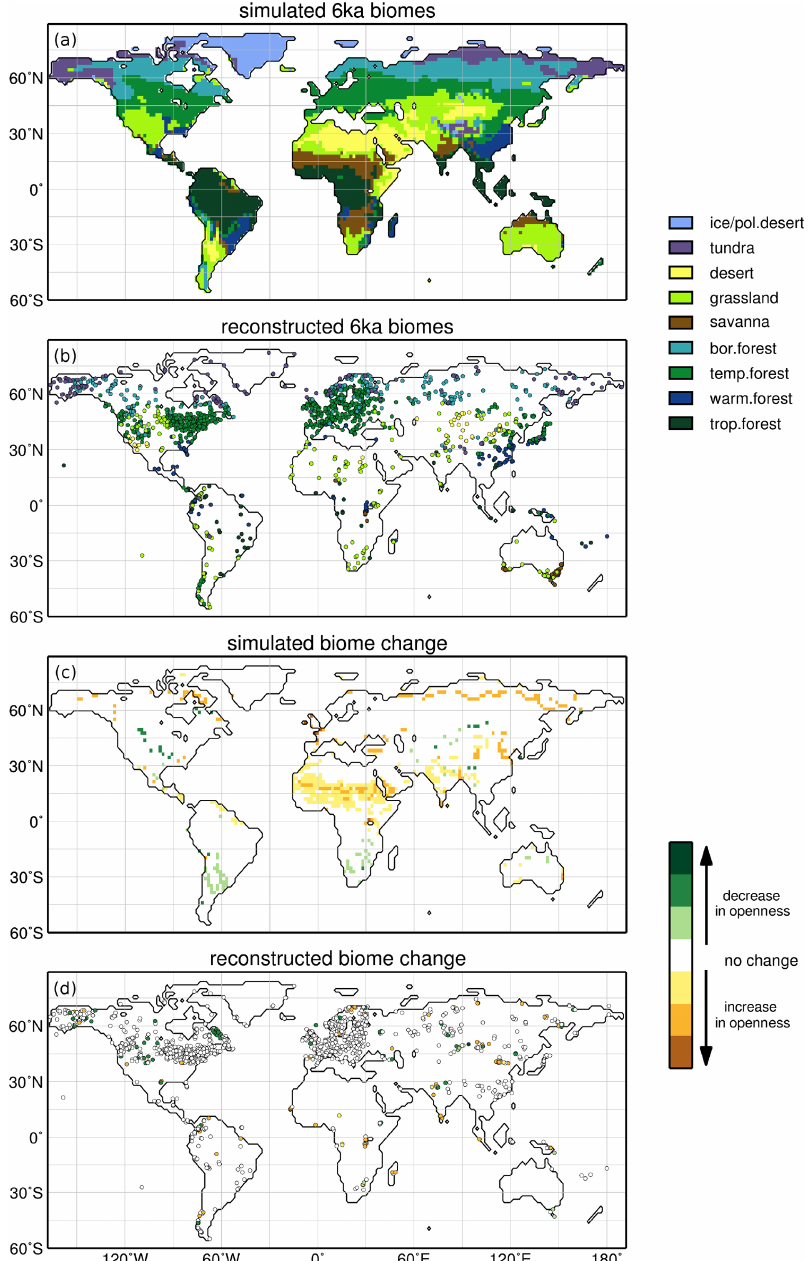
Figure 1. Simulated (a) and reconstructed (b) biomes for the 6ka time slice and the simulated (c) and reconstructed (d) change in vegetation between 6ka and the pre-industrial (PI) era, expressed in terms of landscape openness. To assess the biome change, the biomes have been further grouped into the main categories of forest, savannas, grassland/tundra and desert. A decrease in openness describes the transition from biomes indicating more open landscape to biomes indicating less open landscape (e.g. desert in 6ka to grasslands or to savannas or to forests in PI). Increase in openness of negative development describes the opposite transition (e.g. from grassland in 6ka to desert in